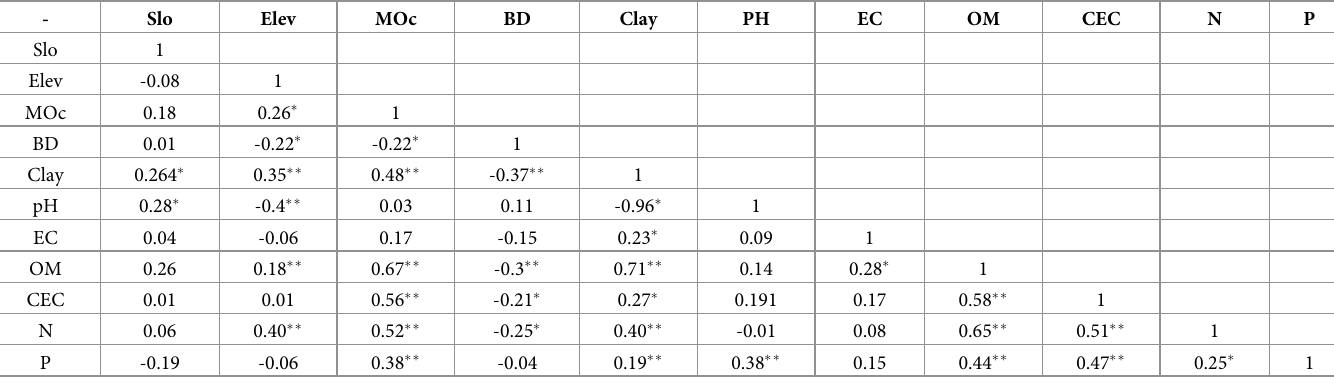
Table 6. Pearson correlation coefficients between environmental variables in Dega Damot District, Northwestern Ethiopia.